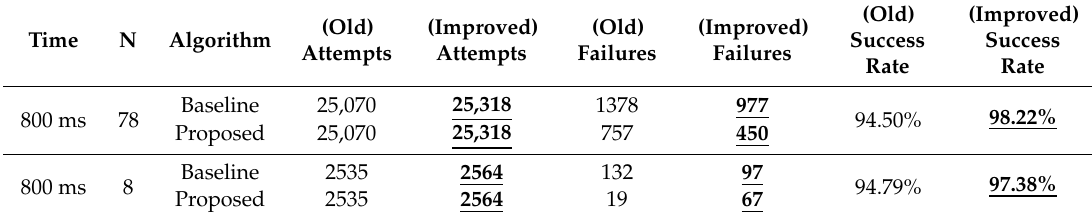
Table 14. Improvements in HSR with improved